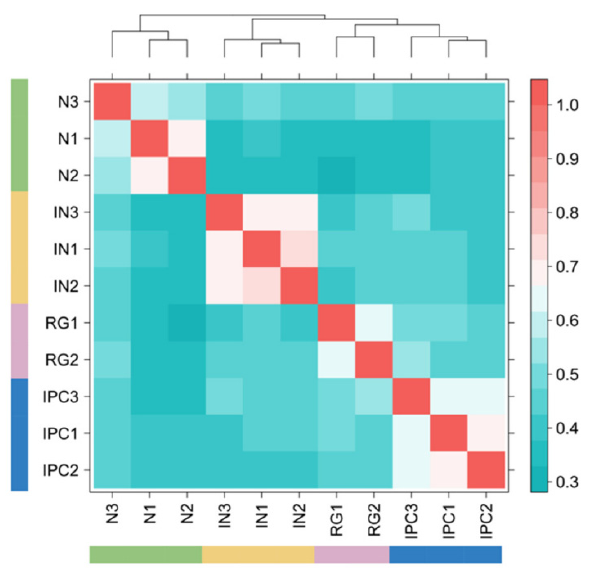
Figure 7. Performance of HPRep in downsampled human neural PLAC-Seq data. HPRep results obtained after downsampling all eleven samples to read depth of the lowest sample.